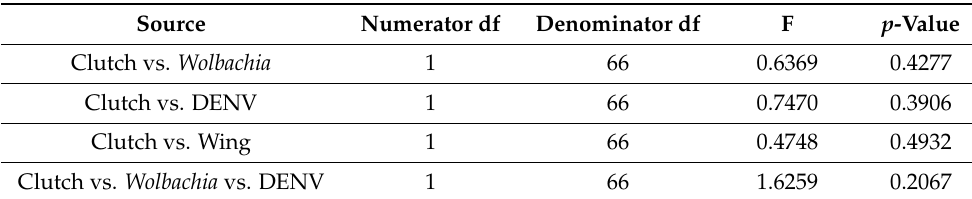
Figure 5. Number of eggs laid per clutch for each of the four groups studied. Observations were restricted to the four first clutches since only a few Ae. aegypti females were still laying after that period. Table 2. Repeated analysis (with clutch taken as the repeat) of the number of eggs laid by Aedes aegypti mosquitoes with Wolbachia and/or DENV